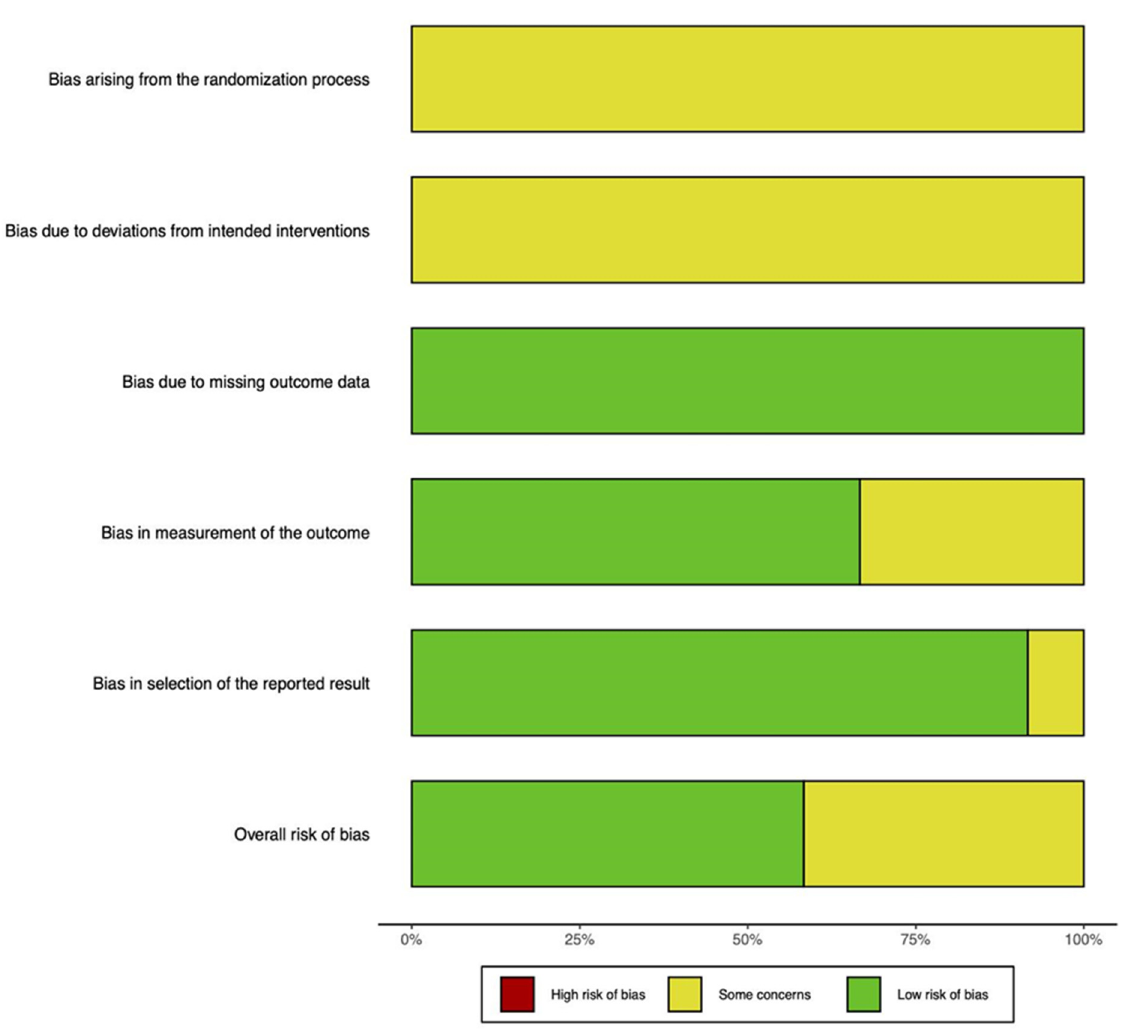
Figure 4. Summary graph showing the overall risk of bias analysis using the RoB 2.0 tool in ran- domized